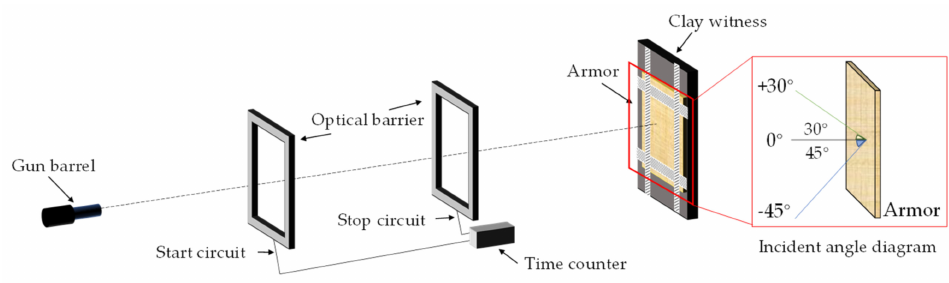
Figure 5. Ballistic experiment